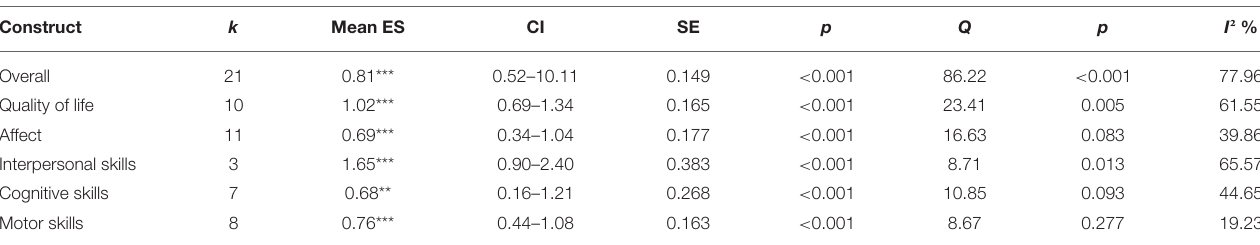
TABLE 7 | Effect sizes only in dance intervention